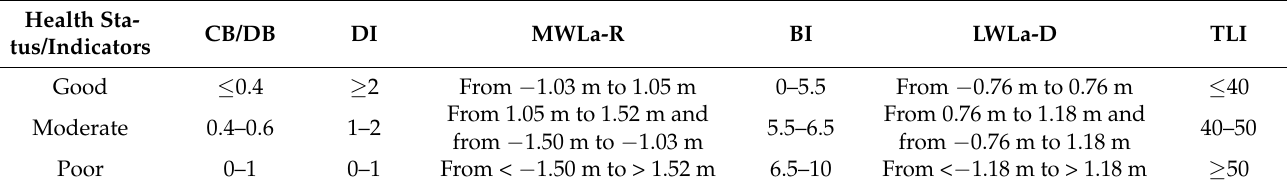
Figure 2. The structure of the aquatic ecosystem health assessment index at Poyang Lake. Table 2. Thresholds of indicators in Poyang Lake.